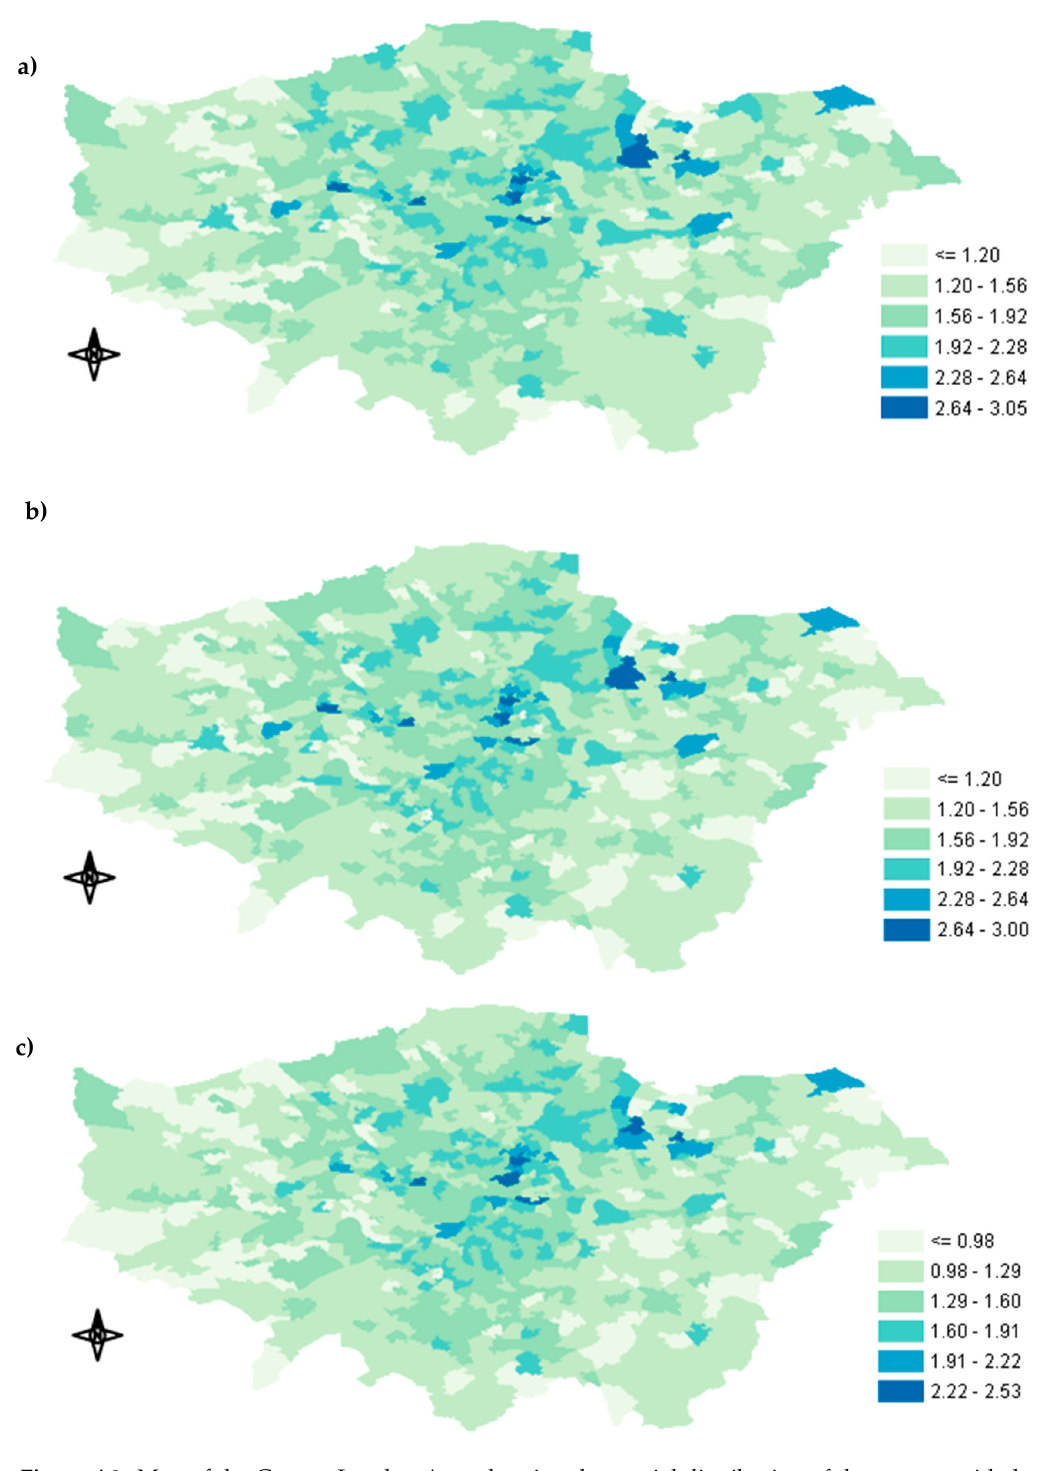
Figure A3 . Map of the Greater London Area showing the spatial distribution of the mean avoided mortality (in death cases): ( a ) Tier 1–2, ( b ) Tier 1–3, ( c ) Tier 1–4.